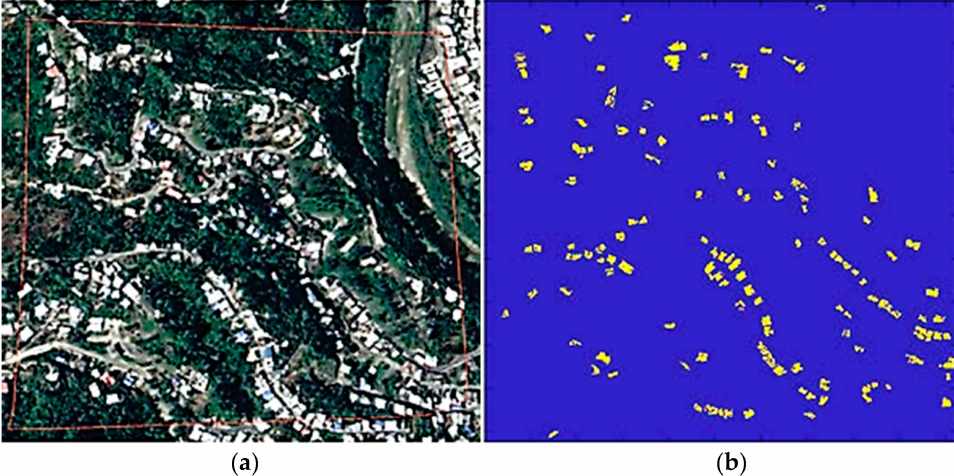
Figure 13. Satellite imagery ( a ) and buildings extracted from LiDAR HAG ( b ) near PR-523 in Utuado, Puerto